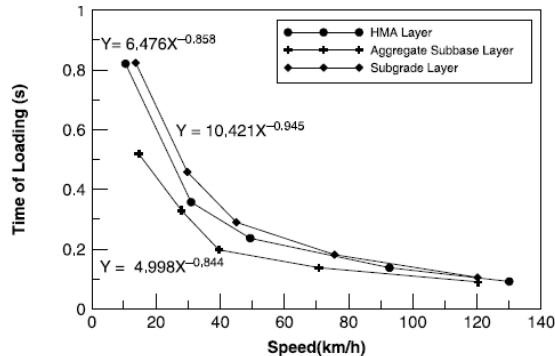
Figure 9. Test section in the state of Maine. Time of loading as a function of speed at different depths in the pavement structure (figure is reproduced from Swett et al. [31]).